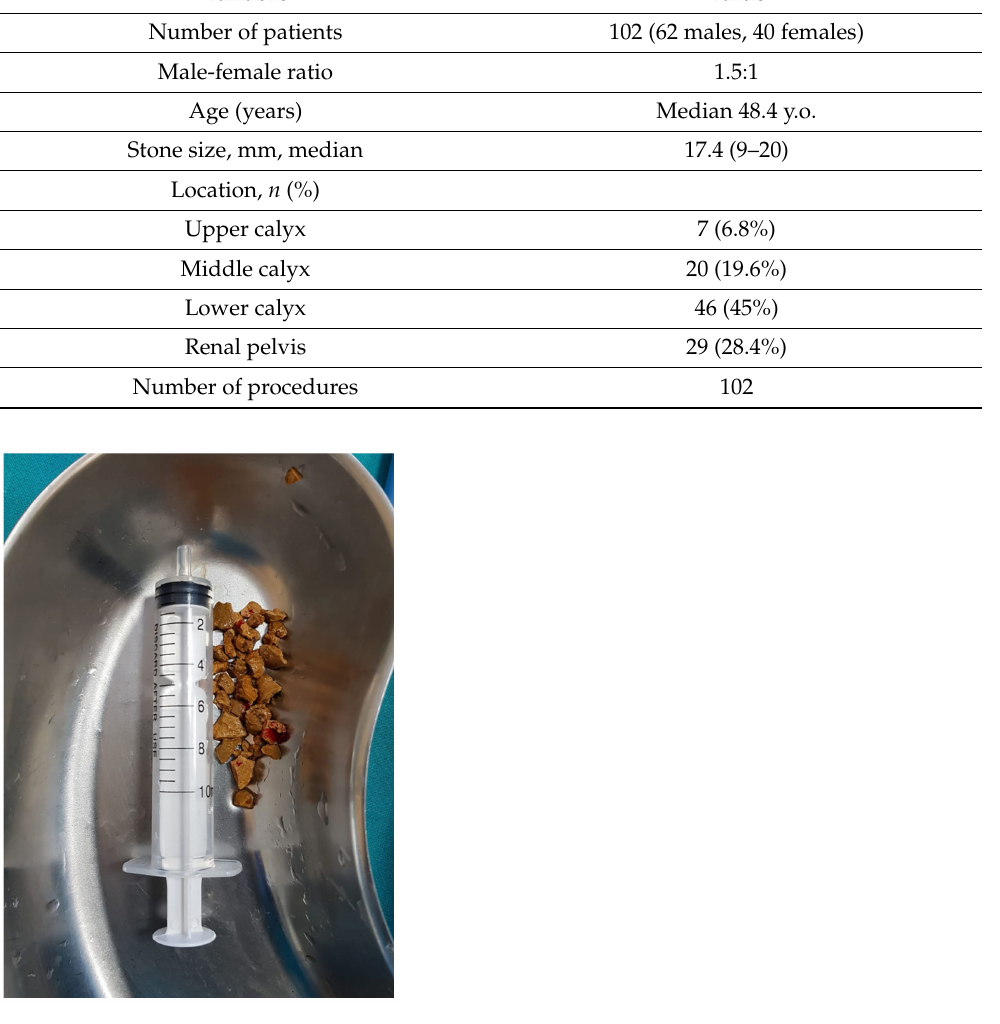
Figure 3. Stone fragments after mini-perc